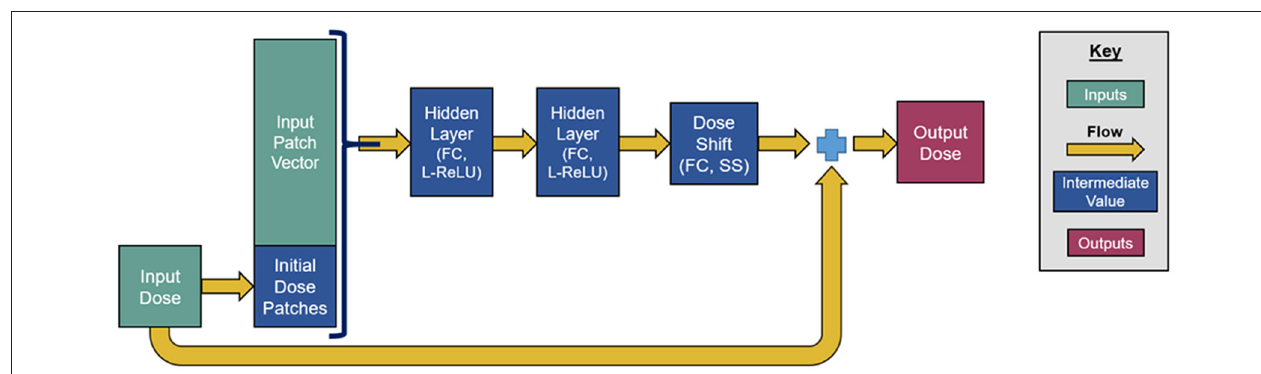
FIGURE 2 | Graphical depiction of a residual block within the neural network.